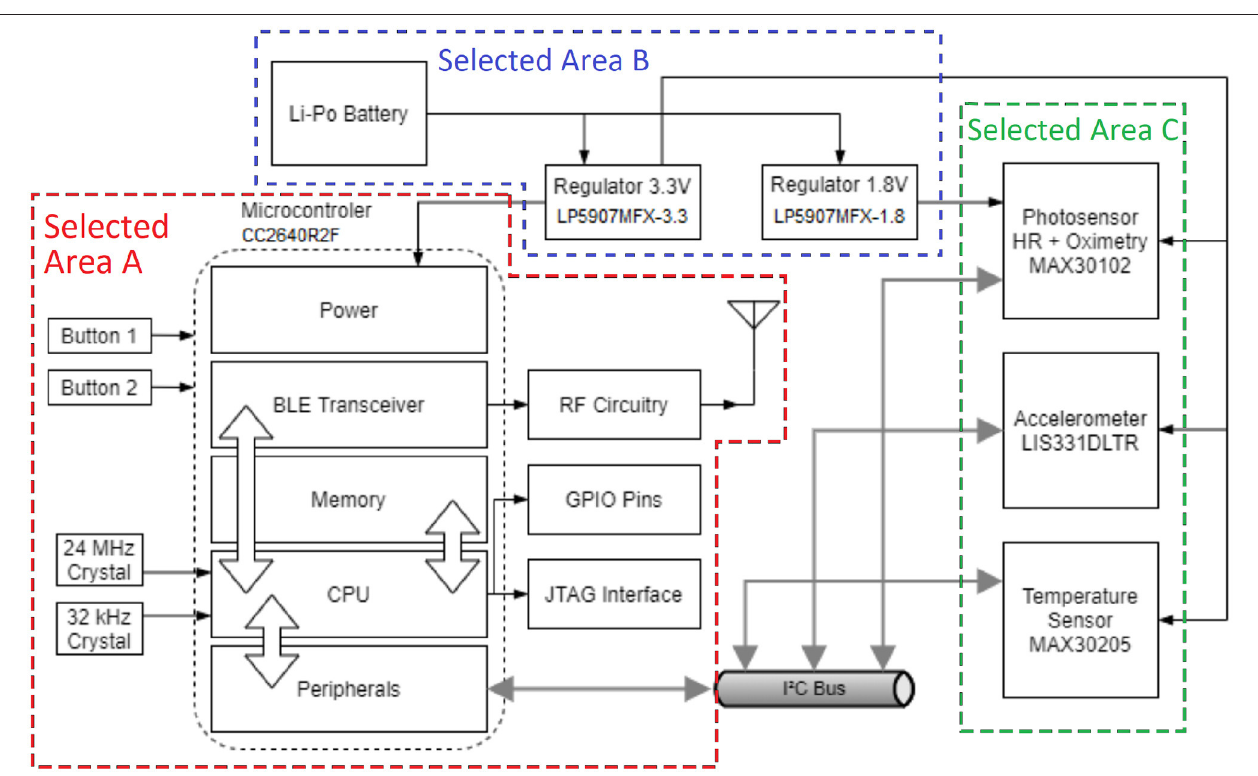
FIGURE 2 | Block diagram showing the functional circuit components of the proposed prototype wristband.